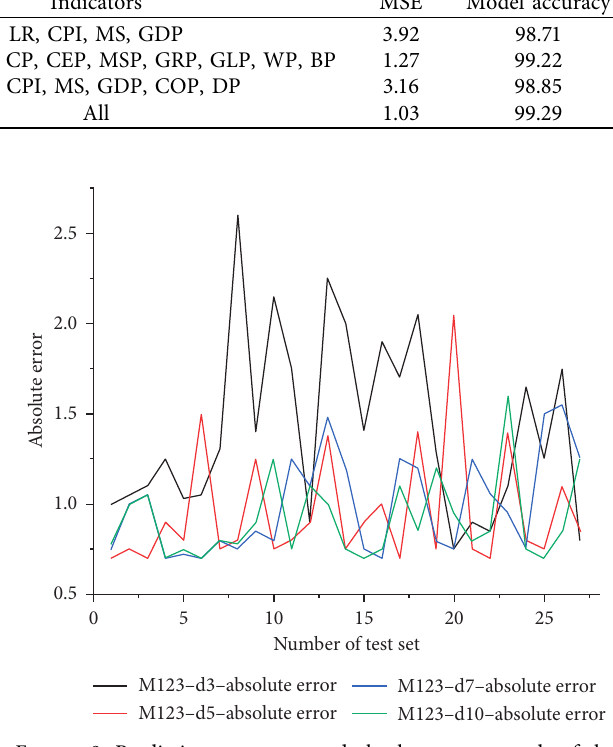
Figure 8: Predictions of the absolute error trends of the four models with different input features. Table 6: Effects of the time series lengths on the accuracy rates of the models.